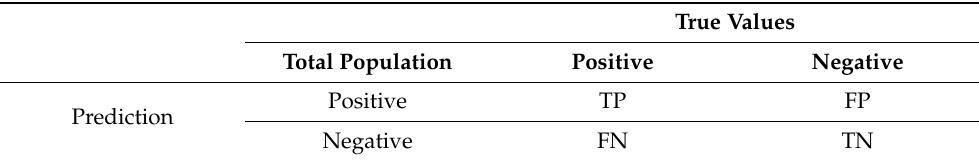
Table 1. Confusion